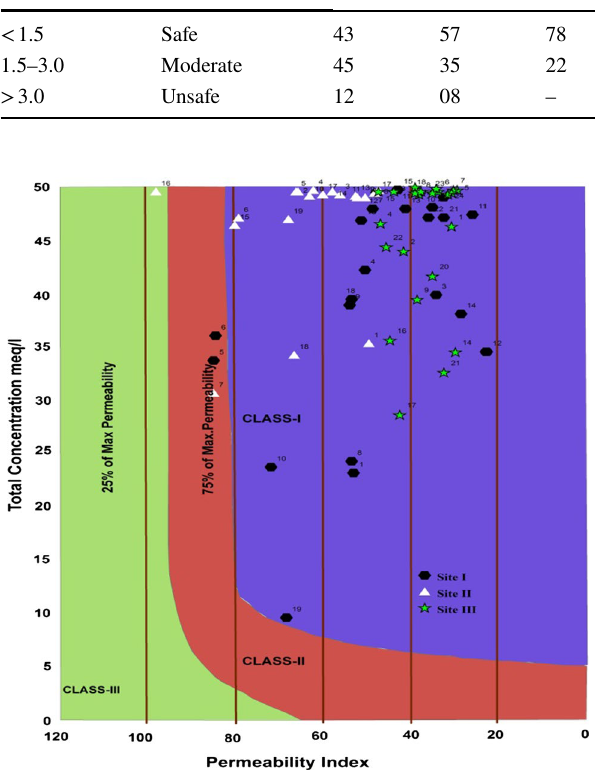
Fig. 6 Doneen classification of irrigation water based on permeability